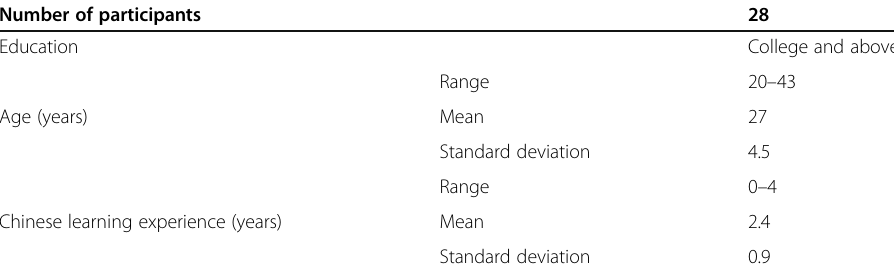
Table 2 Background information of the CFL